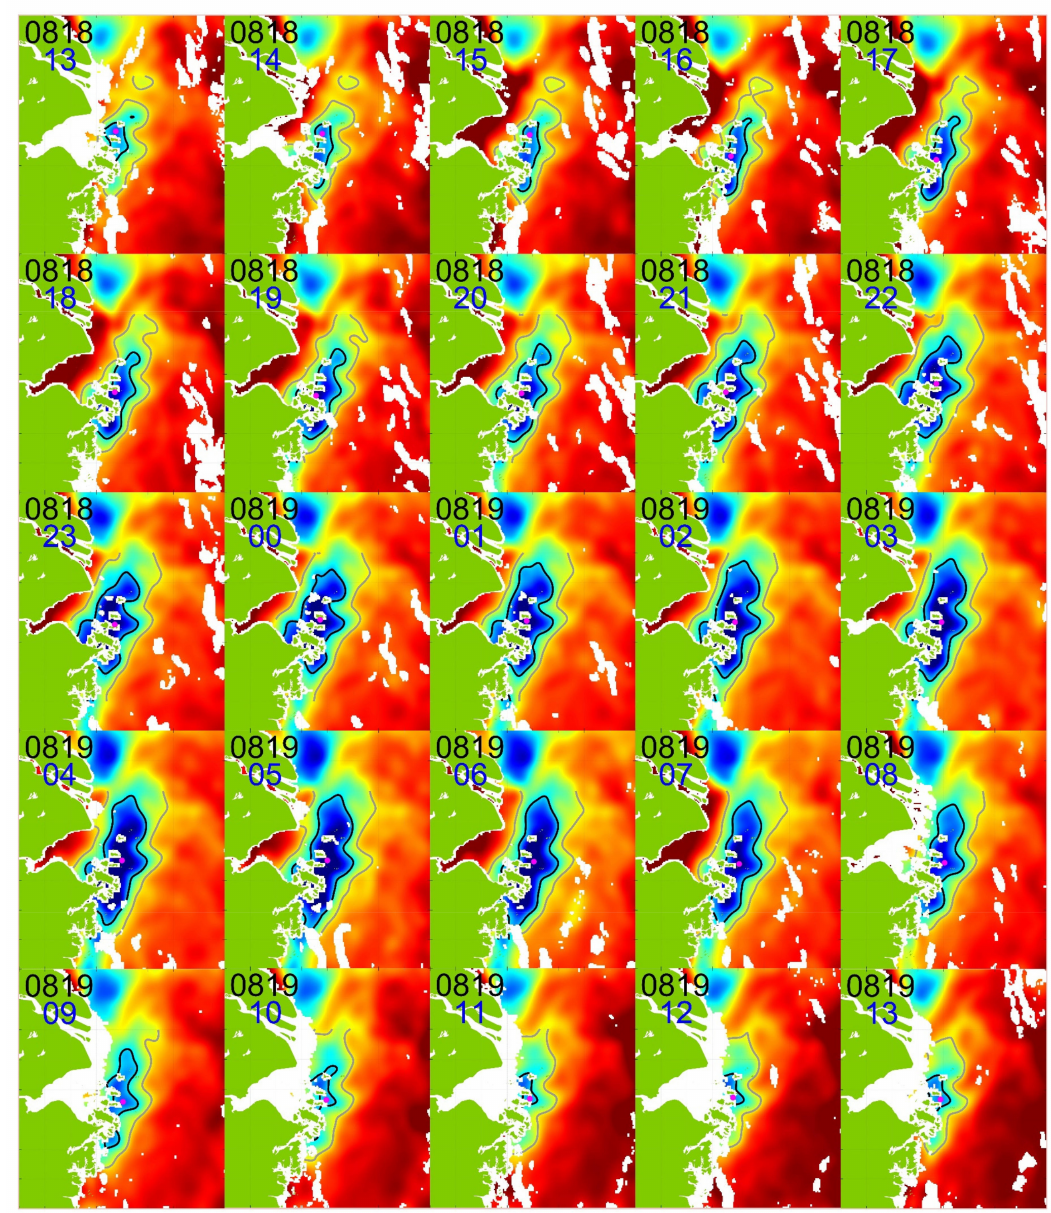
Figure 9. SST images of a complete quasi − 24 h periodic surface upwelling process between 13:00 18 August and 13:00 19 August 2020 (Beijing time, UTC + 8). During the intensification stage, between 13:00 18th and 04:00 19th, the UPI is slowly intensifying, from 1.7 ◦ C to near 3 ◦ C, and the core area expanded from 1264 km 2 to 10,414 km 2 (Figures 9 and 10a). Under the eastward advection of tidal current (the magenta line in Figure 10b), the center of the upwelling moved seaward from 112.38 ◦ E to 122.44 ◦ E (the green line in Figure 10b); After 18:00, the center moved shoreward from 122.36 ◦ E to 122.26 ◦ E within 3 h pushed by the westward tidal current; finally, the center moved seaward again from 122.26 ◦ E to 122.5 ◦ E between 21:00 18 and 04:00 19. The JAXA-SST spatial pattern (Figure 9) indicates that the core area is shaped as an irregular elliptical with a long axis pointing northeast. The boundaries of the core area (the black line in Figure 9) and the mixed area (the gray line in Figure 9) began to expand eastward and northward throughout the stage, and the northern boundary of the core area reached outside the Yangtze River